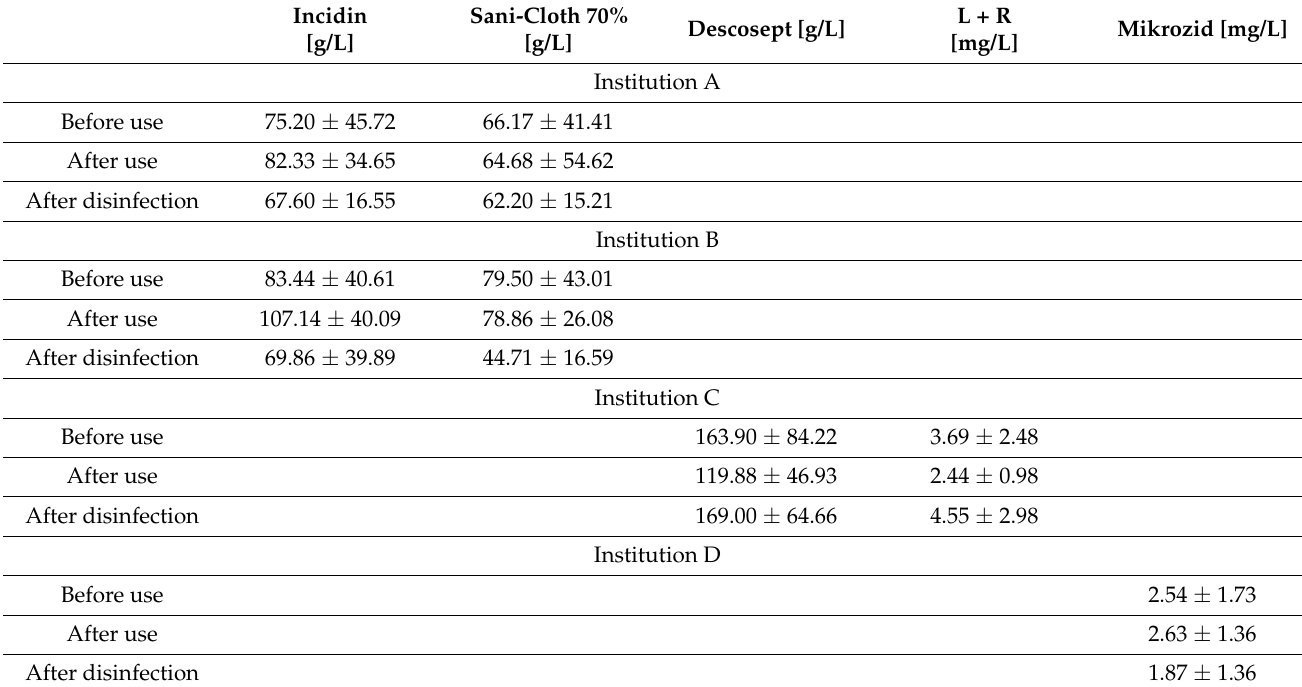
Table 2. Average MIC values for all five tested disinfectants across facilities at different sampling occasions. Incidin